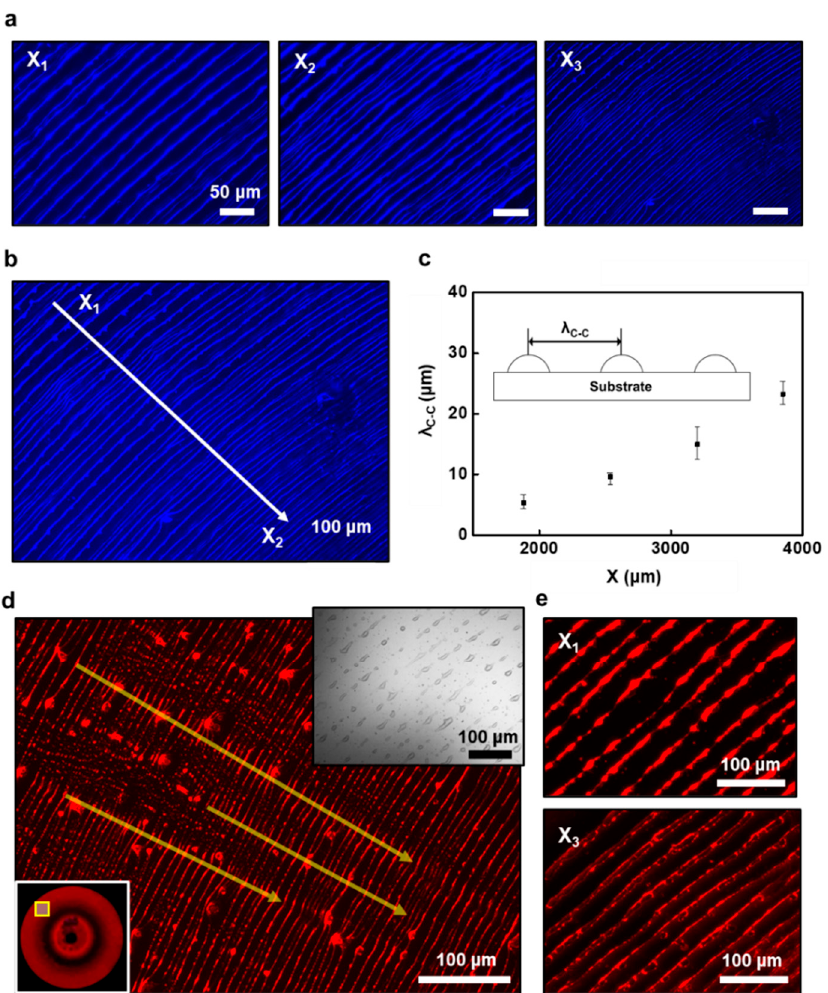
Figure 3. Multiple ring arrays of CsPbBr 3 and CsPbI 3 QDs. ( a ) Fluorescence microscopic images from three different positions ( X 1 , X 2 , and X 3 from outermost to innermost regions) of the patterned arrays of CsPbBr 3 QD rings; highly dense arrays of the rings with blue-emission under the fluorescence. ( b ) A typical microscopic image shows the finite aligned arrays structure of the CsPbBr 3 QDs with a finely tuned controllability. ( c ) A center-to-center distance ( λ c-c ) of the radially formed CsPbBr 3 QD rings plotted as a distance from the contact-center shows a gradient fashion. ( d ) Typical optical micrograph of the patterned array of CsPbI 3 QD ring with red-emission under the fluorescence. ( e ) Highly magnified optical micrographs with discretely patterned arrays of QD rings in a gradient trend at the outermost (upper) and innermost regions (lower).